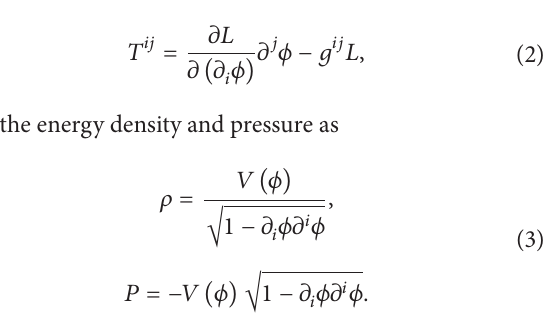
which captured a lot of attention (see, for instance, [8]).